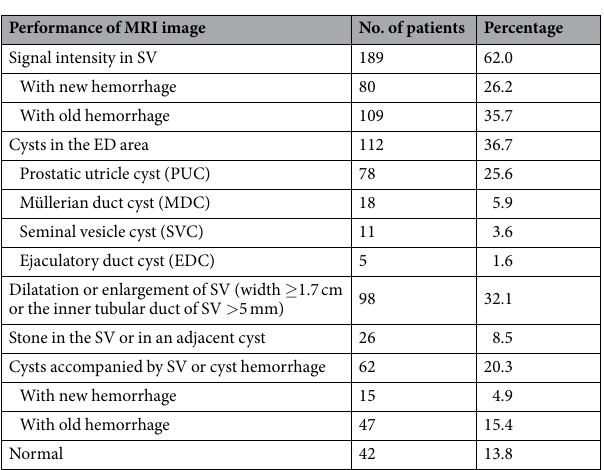
Table 2. MRI image characteristics of 305 patients with refractory hematospermia and/or